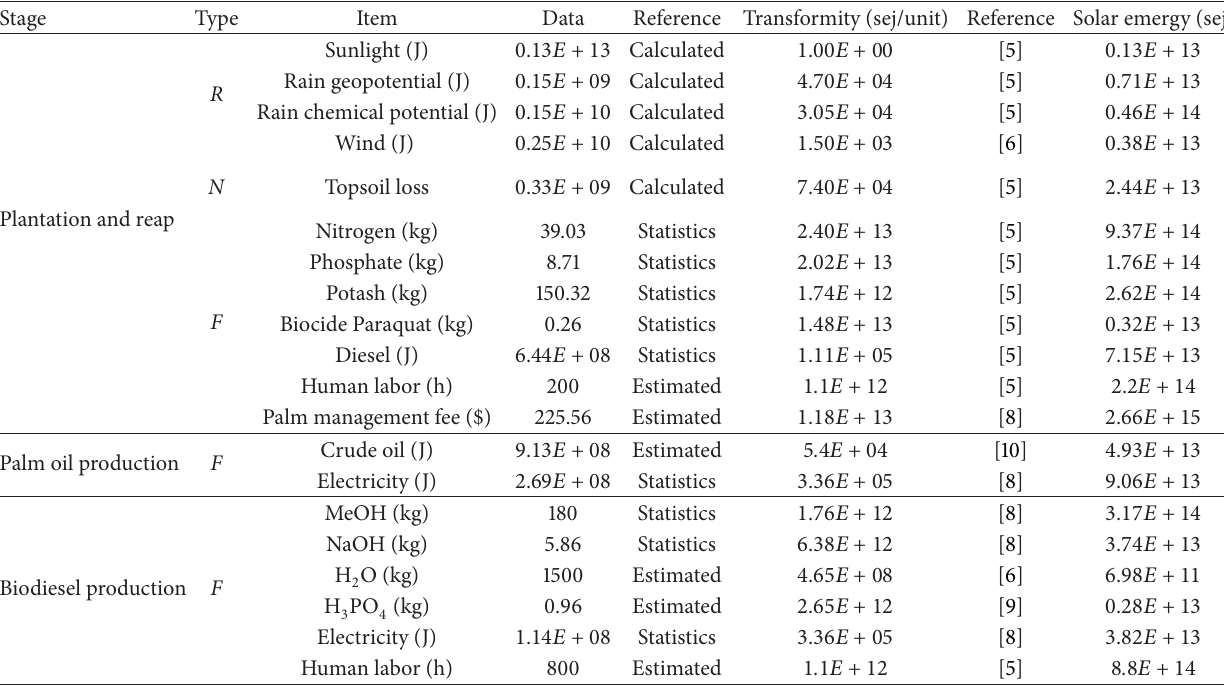
Table 6: Emergy analysis table for palm-based biodiesel.